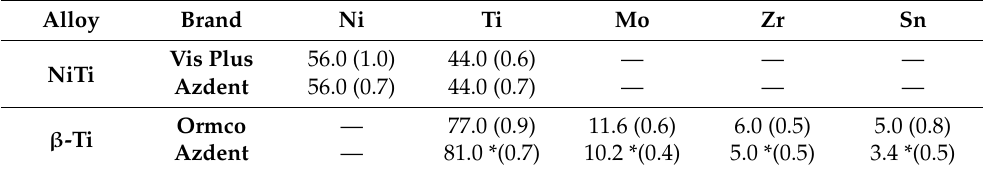
Table 6. Determined three-point bending test parameters of β -Ti products: offset bending force F S(0,1) , force-deflection rate F Δ , flexural modulus of elasticity E (standard deviation), and statistical analysis result p values.